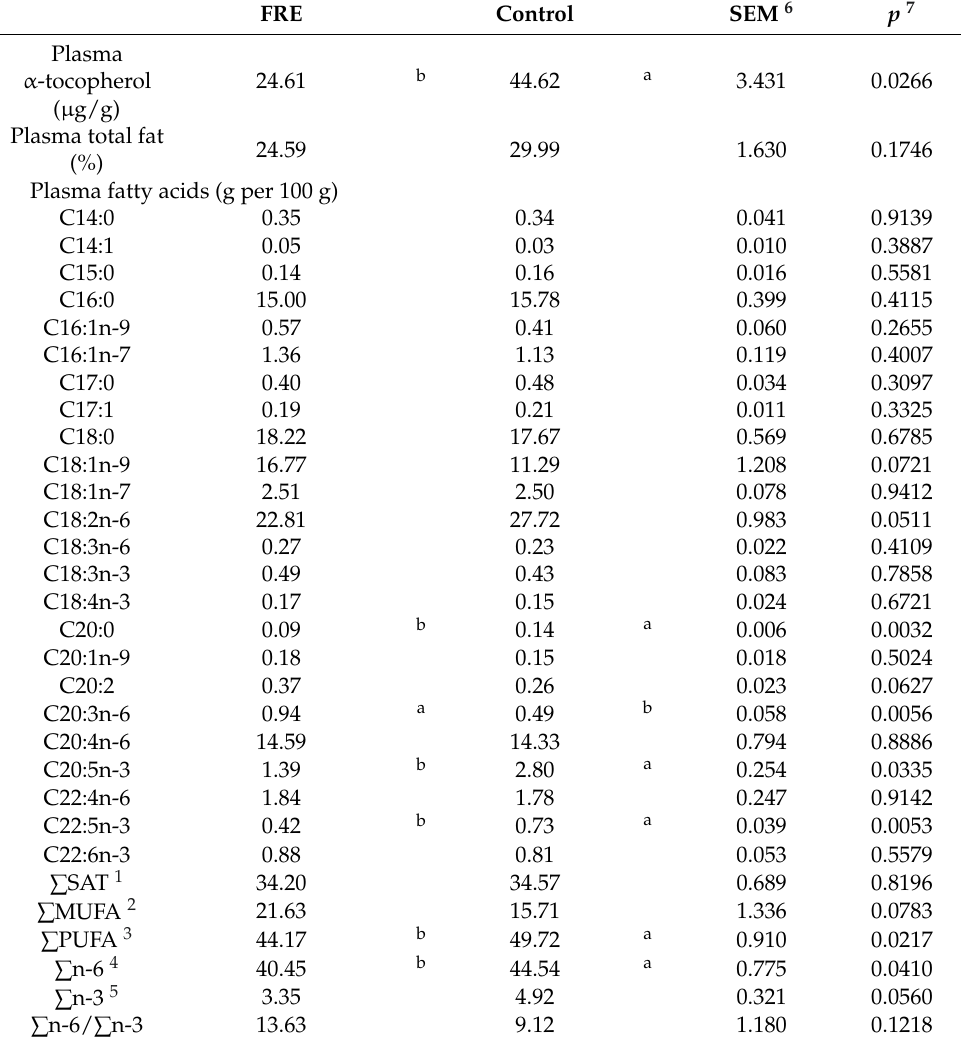
Table 2. Concentration of α -tocopherol, fat and fatty acid profile of plasma samples from the FRE (food-responsive enteropathy) and control